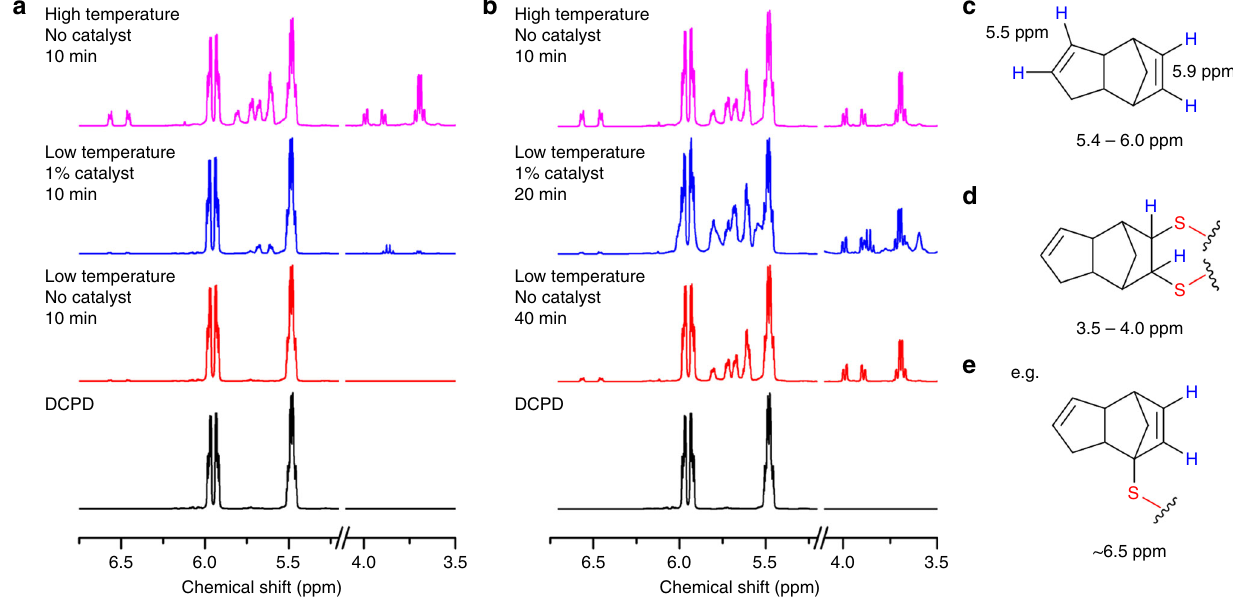
Fig. 5 1 HNMR spectra of DCPD at various stages of reaction with sulfur: a After 10 min of reaction and, b at approximately the same stage of reaction, but under different conditions. Low temperature reactions were carried out at 135 °C, and high temperature at 185 °C. c Before reaction, the vinylic protons of DCPD appear at 5.5 – 5.9 ppm. d Reaction with sulfur yields S – C – H protons that appear in the 3.5 – 4 ppm region. e Proton substitution at the α position, without addition across the double bond, results in C = C( – H) – C – S proton environments that are shifted down fi eld w.r.t. their original positions, appearing at ~6.5 ppm NATURE COMMUNICATIONS| (2019) 10:647